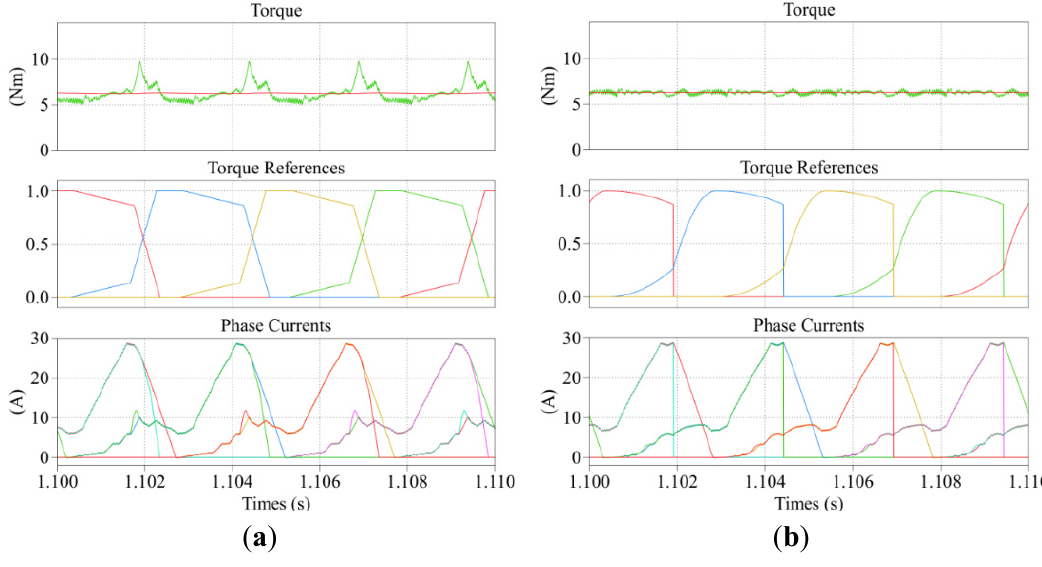
Figure 12. Simulation results at 1000 rpm: ( a ) asymmetric TSF; ( b ) non-unity